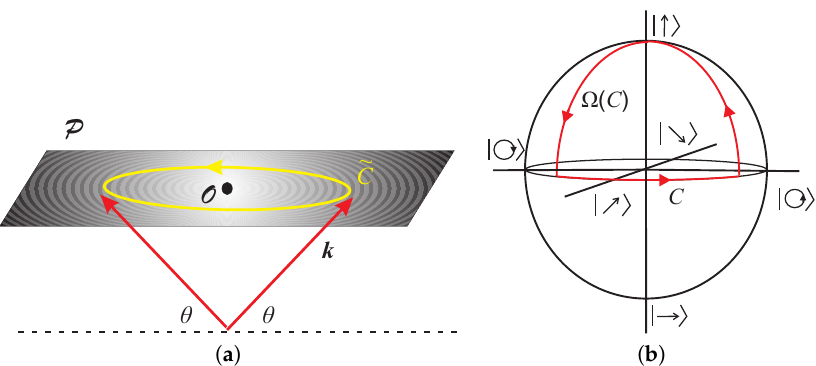
Figure 3. ( a ) As the light travels along the helically-wound optical fiber, the tip of its momentum vector k is confined to a momentum-space plane, P , and traces out a curve ˜ C which encircles point O . The winding number ν ( ˜ C ) of the light’s path is the number of times ˜ C circles O . ( b ) As ˜ C repeatedly traces out a circle in momentum space, the quantum state of the light traces out a closed path C on the Bloch sphere. In the process, the quantum state gains a non-trivial geometrical Berry phase, γ ( C ) , which depends on the winding number ν ( ˜ C ) , the area Ω ( C ) subtended by the curve C relative to the origin, and the photon helicity σ